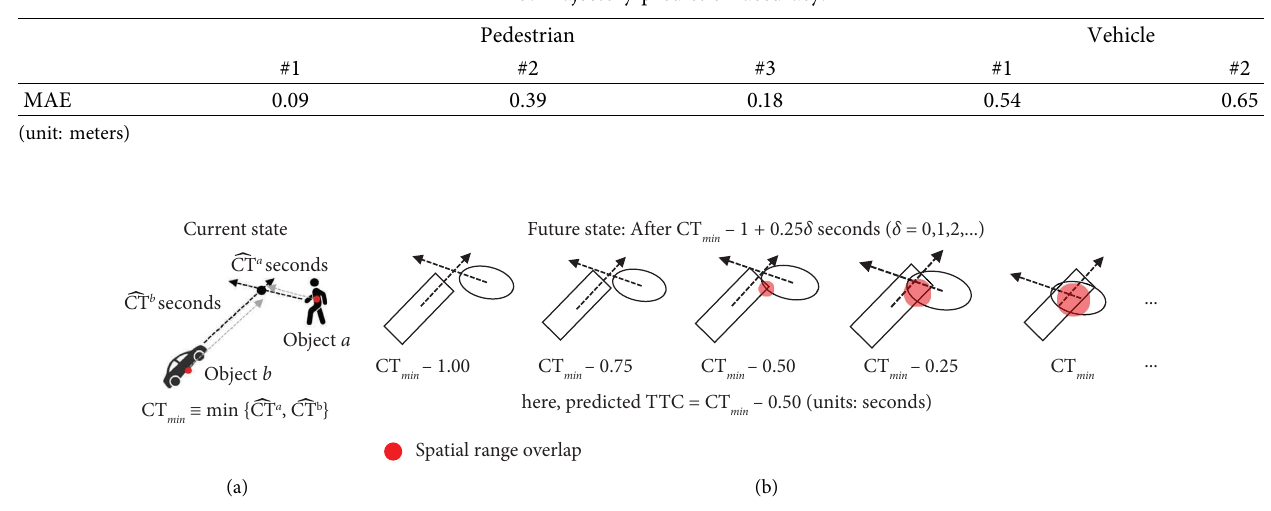
a b is determined based on 􏽣 CT and 􏽣 CT . (b) If min